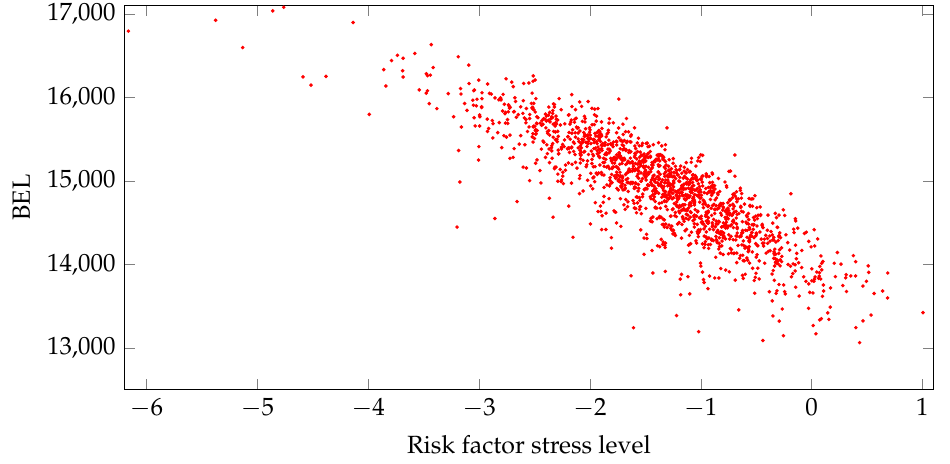
Figure 3. Nested simulation values of best estimate of liabilities with respect to a financial risk factor The nested simulations set comprises the e.g. L = 820 to L = 6554 validation points of which 210 the scenarios correspond to the e.g. highest 2.5% to 5% losses from the full loss distribution forecast 211